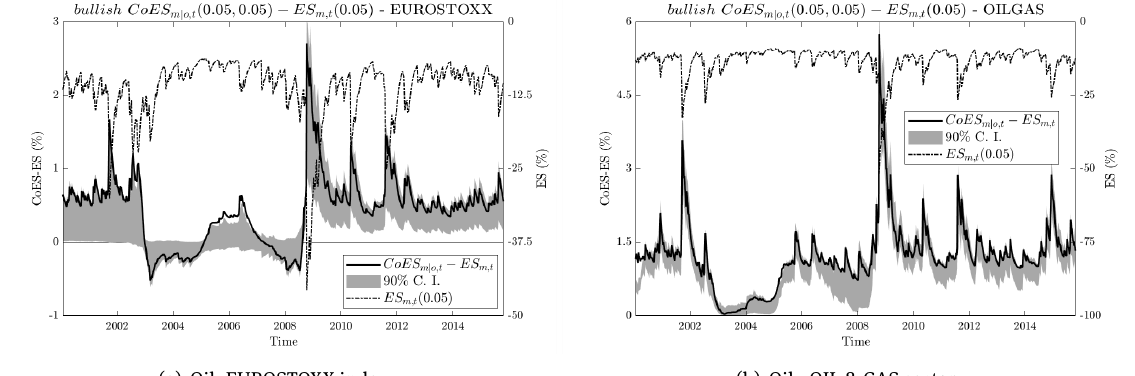
Figure 20a: CoES m | o , t (0.05, 0.05) for a certain sector given a bullish scenario for oil prices